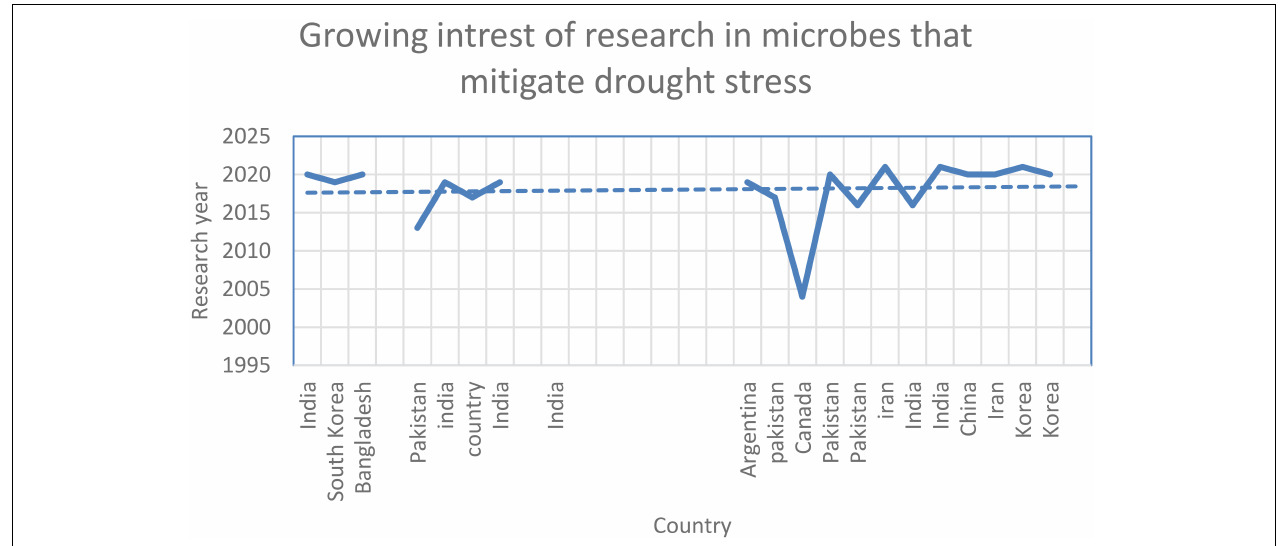
FIGURE 5 | Growing interest in research related to microbes that mitigate drought